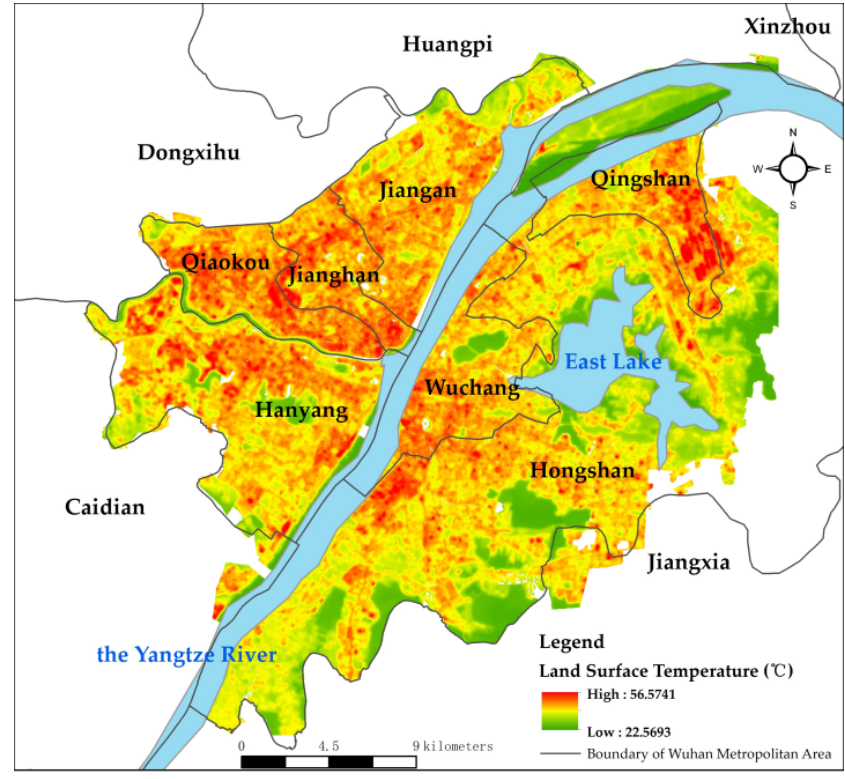
Figure 7. Spatial distribution of LST.